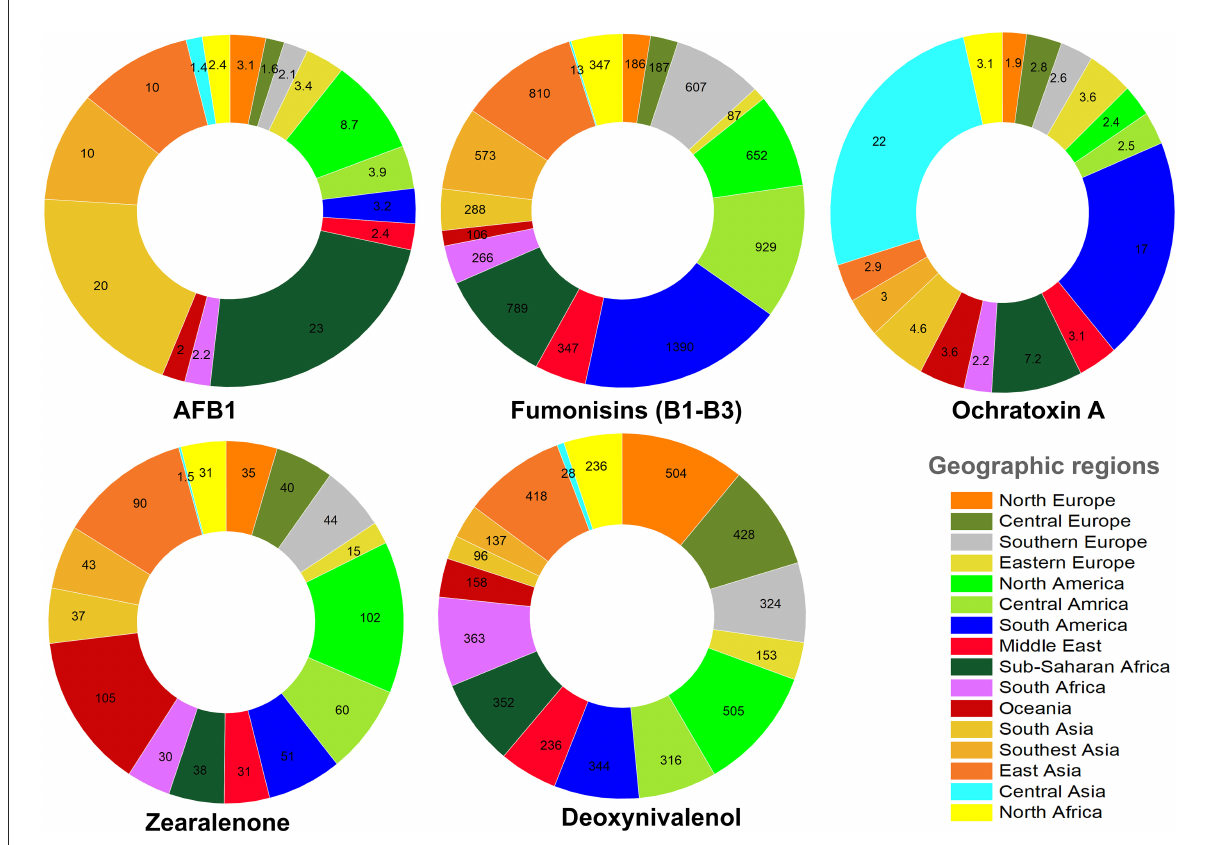
FIGURE7 The median concentration ( µ g/kg) of AFB1 and other mycotoxins in feed from different geographic